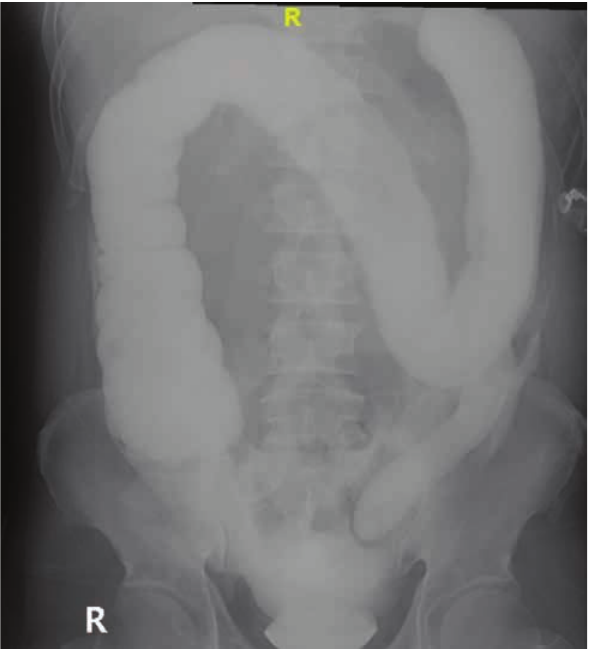
Figure 4: (Case 2) Plain abdominal x-ray done eight hours after the distal loopogram procedure showed extraluminal